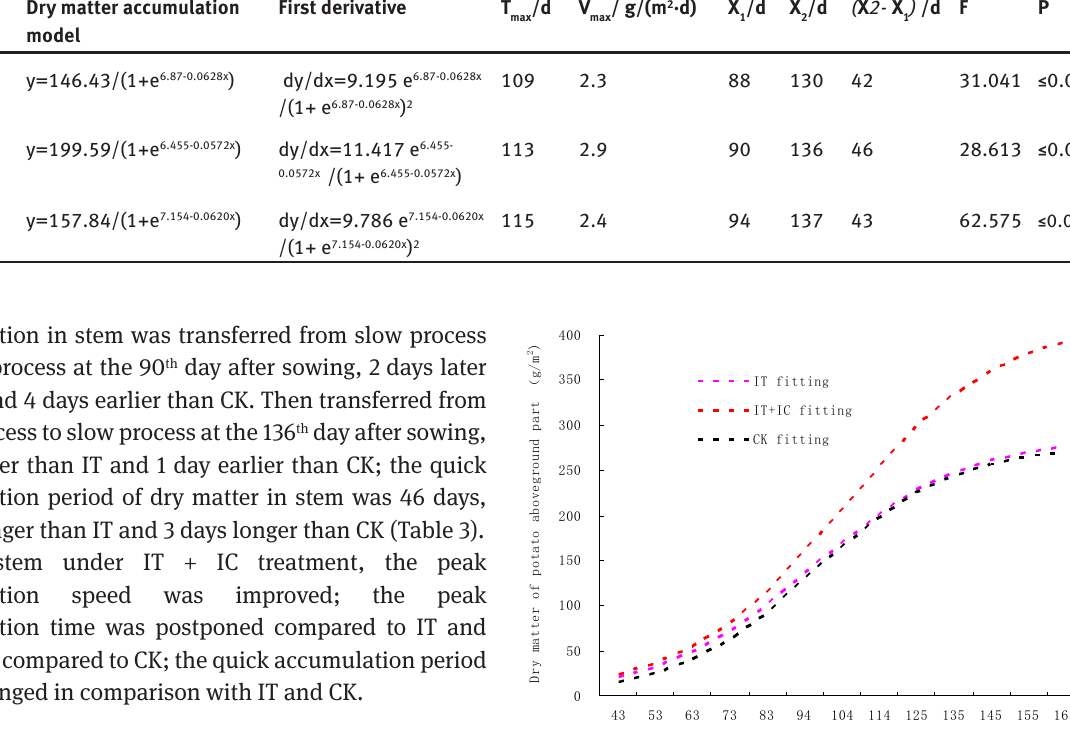
Table 3: Dynamic simulation and characteristic parameters of dry matter accumulation for potato stem in different treatments. Treatment Dry matter accumulation model